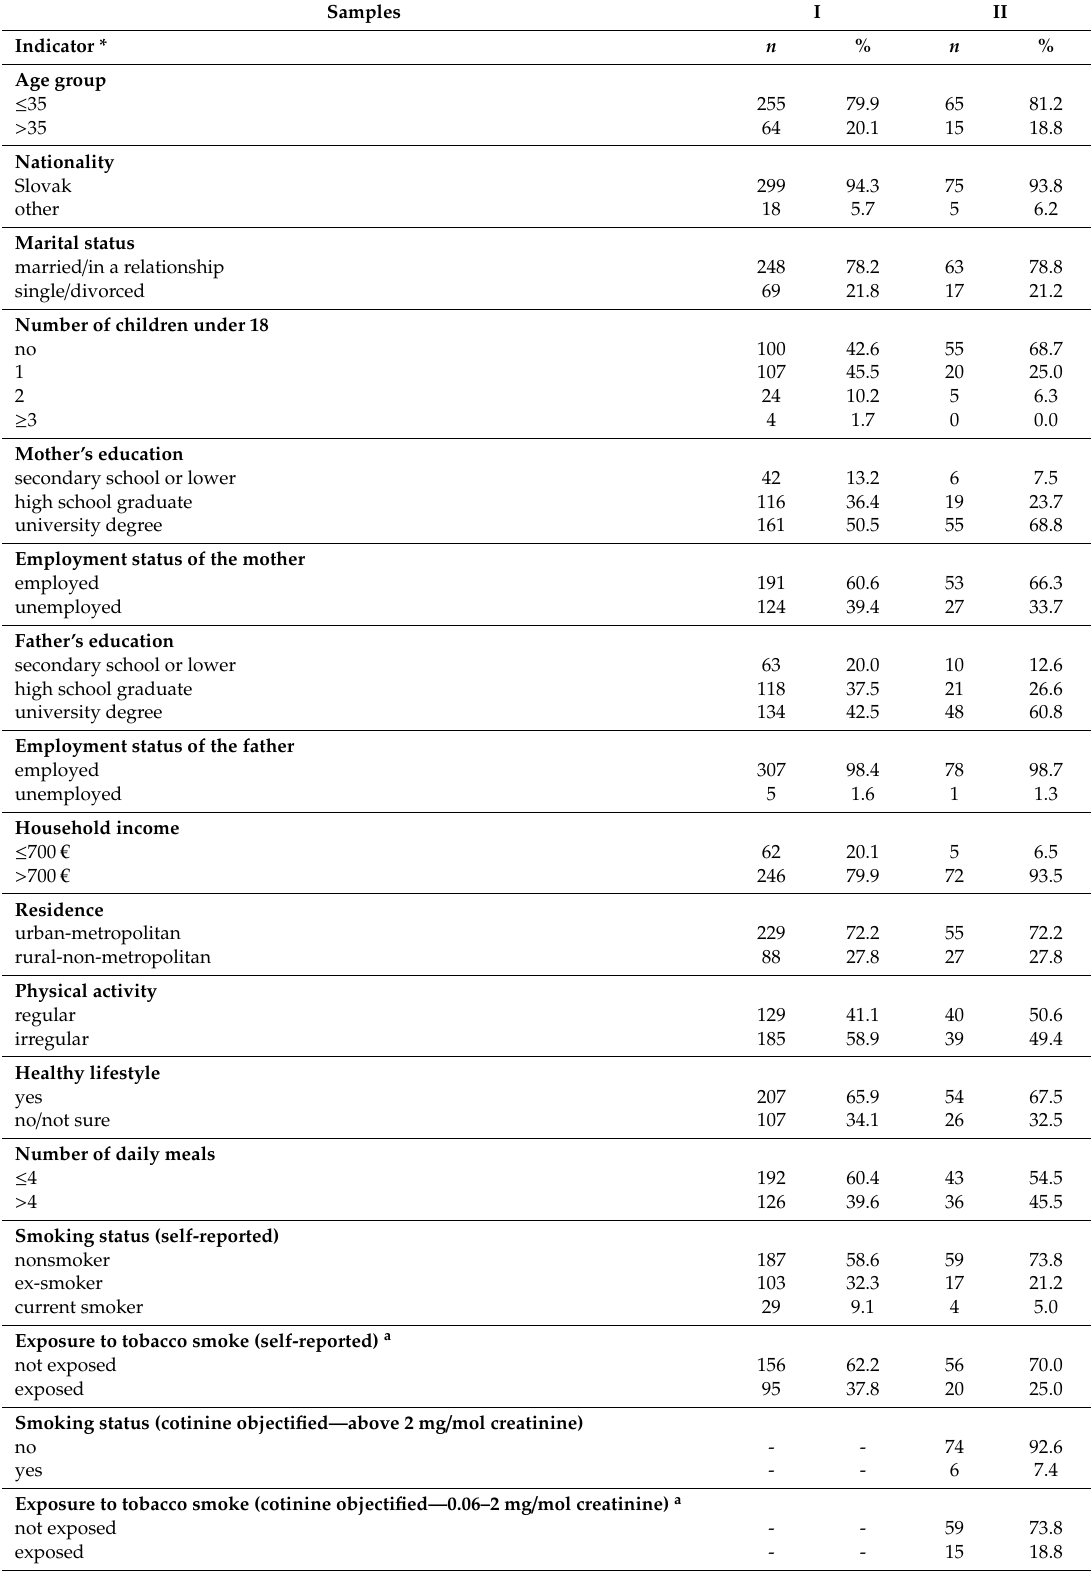
Table 1. Characteristics of two samples of pregnant women (I ( n = 319), II ( n = 80)).